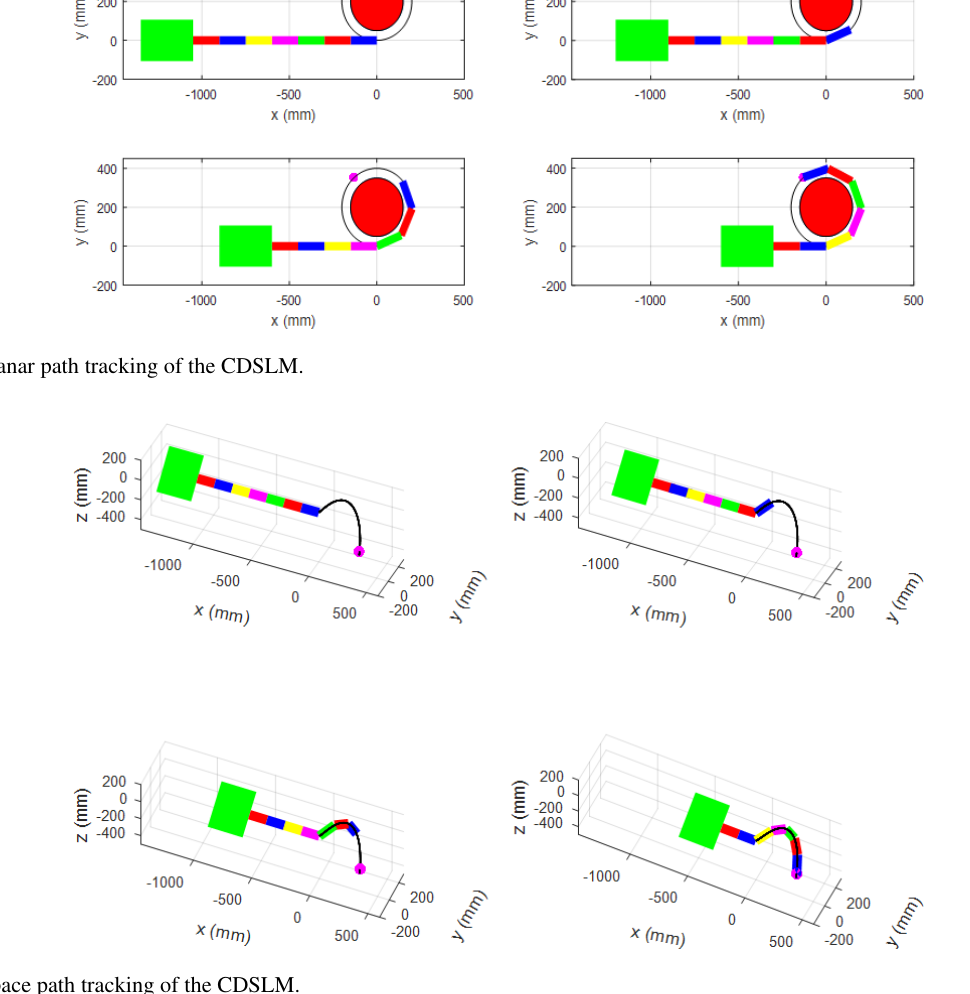
Figure 12. Space path tracking of the CDSLM.